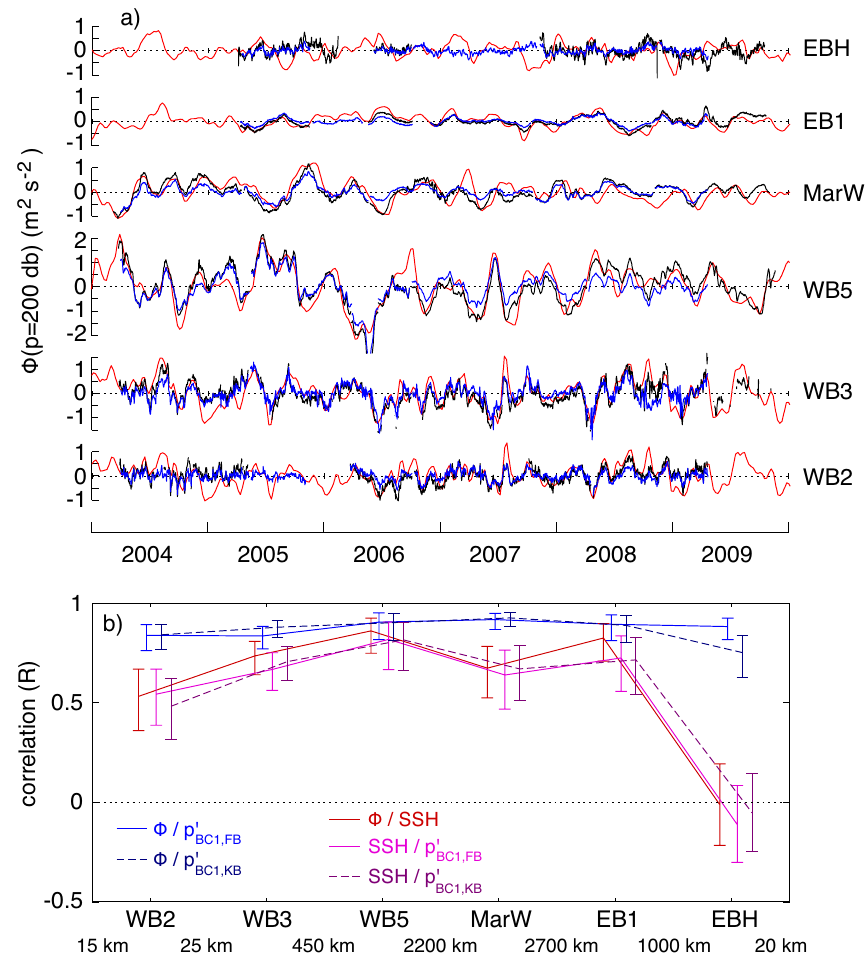
Fig. 7. Geopotential anomaly at 200 db. (a) Time series of geopotential anomaly for the original measurement ( 8 , black), the amplitude of = P = 200 ) , blue), and SSH ( gη , red). Stations are listed from the western boundary the flat-bottomed BC1 mode at 200db ( p 0 1 F 1 (p BC1 at the bottom to the eastern boundary at the top. (b) Correlations ( R ) between quantities shown earlier: 8 and p 0 (solid blue), 8 and BC1,FB p 0 (dashed blue), 8 and SSH (red), SSH and p 0 (pink), and SSH and p 0 (purple). Prior to calculating the correlations, 8 , BC1,KB BC1,FB BC1,KB p 0 , and p 0 are 10-day low-pass filtered. Error bars are calculated with a Fischer z-transform, and the degrees of freedom is the BC1,FB BC1,KB length of the time-series divided by the integral time-scale. Distances between the stations and to the coastlines are shown at the